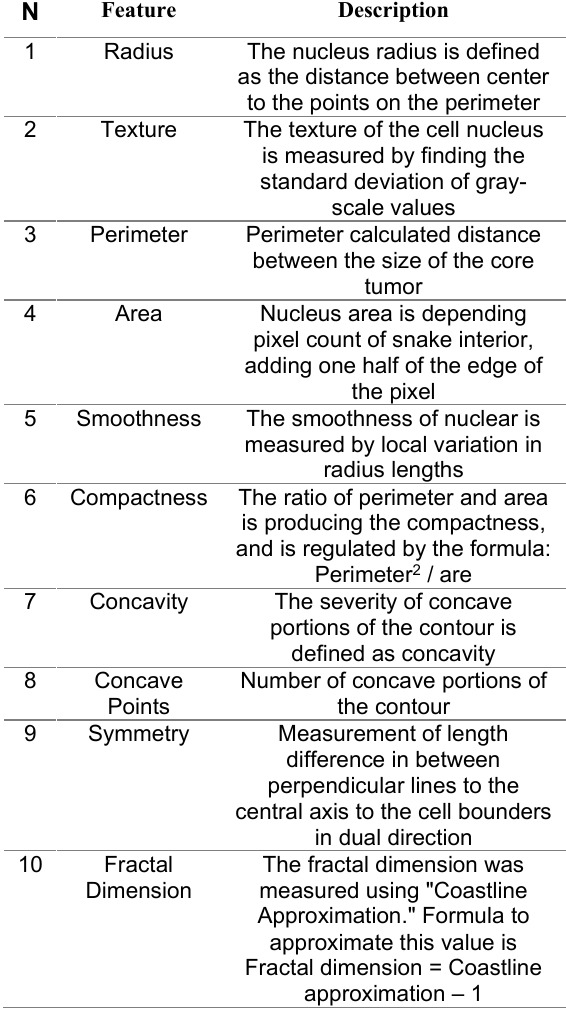
Table 1. Individual feature description of cell